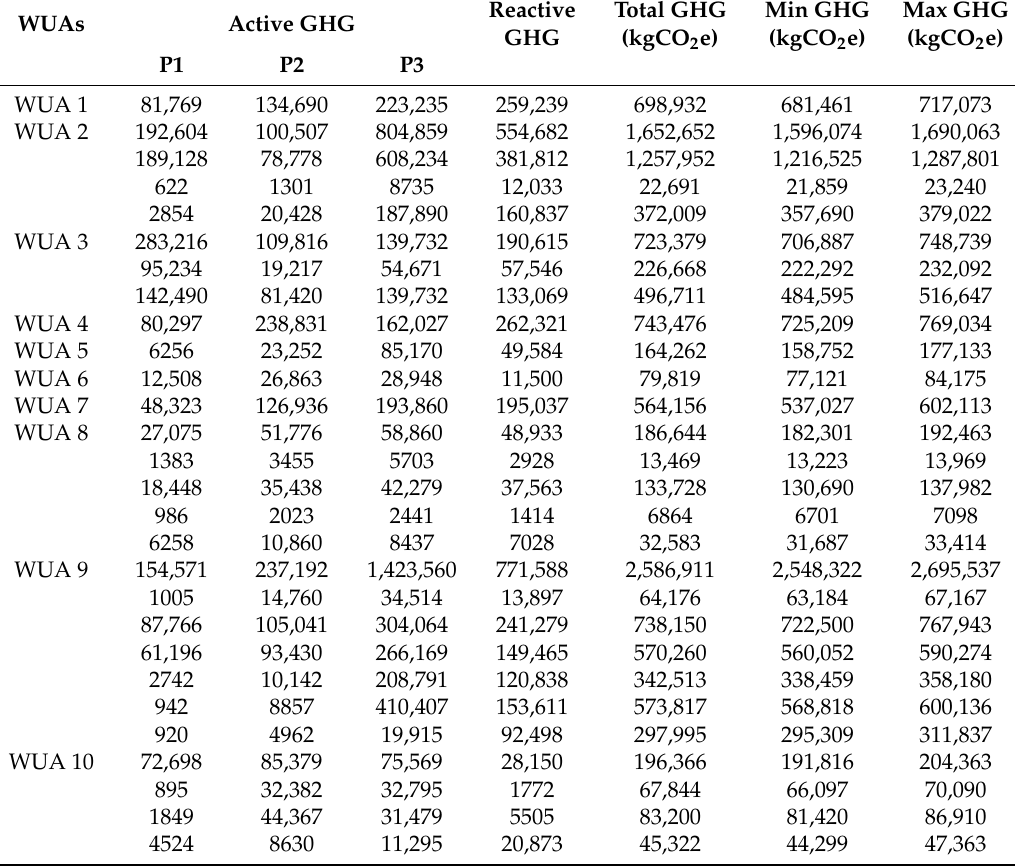
Table 3. GHG emissions (kgCO 2 e) according to active and reactive power per WUAs and potential emission de emissions. Maximum and minimum GHG (Approach